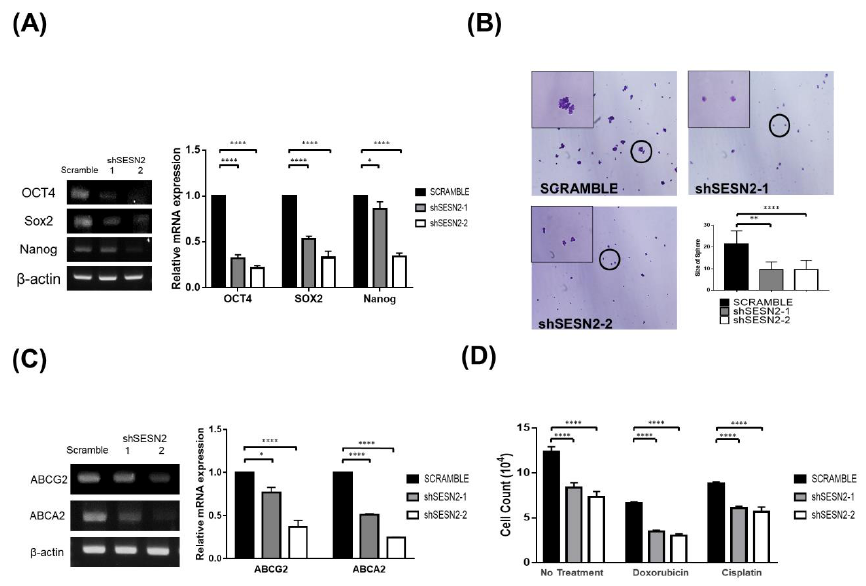
Figure 2. E ff ect of Sestrin2 expression on stemness and drug resistance in A549 cells. ( A ) Expression of stemness marker in scramble and shSESN2 A549 cells was analyzed using RT-PCR. mRNA expression relative to scramble control is shown in the graph. ( B ) Sphere-forming assay of scramble and Sestrin2 knockdown A549 cells. Cells were seeded in a petri dish and cultured in sphere-forming media. Spheres were evaluated after 5 days of culture using crystal violet, and then photos were taken. The size of the spheres was measured by ImageJ. The enlarged photo at the top left represents spheres in a circle. ( C ) Expression of the drug resistance marker genes ( ABCG2 , ABCA2 ) in scramble and shSESN2